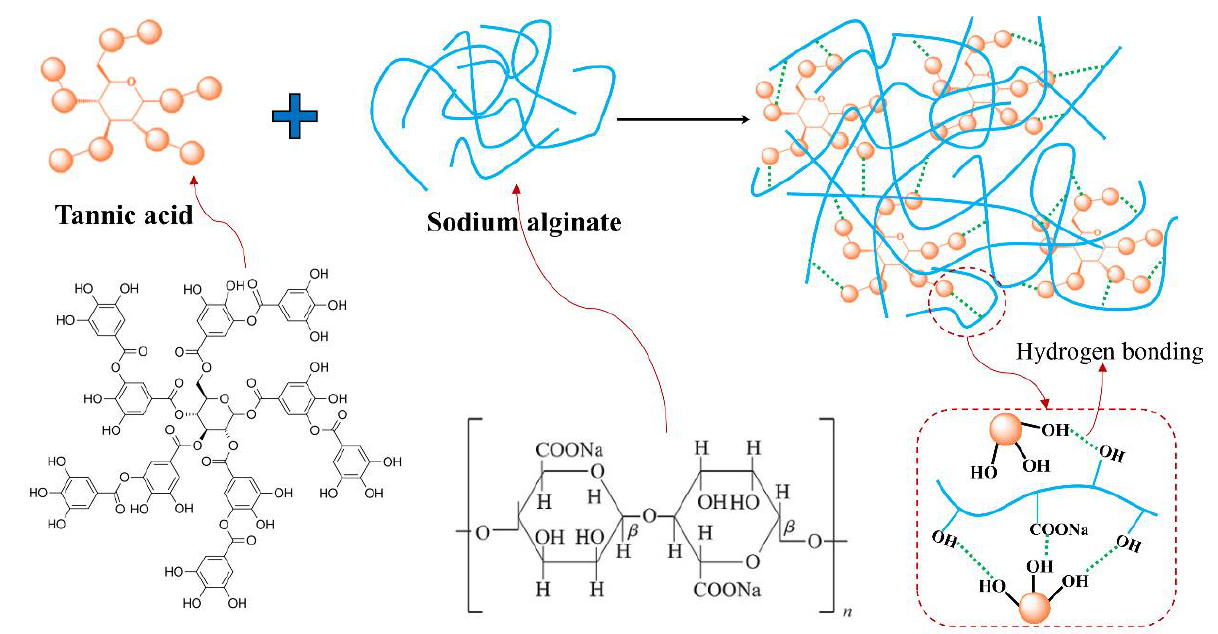
Figure 2. Illustration of intermolecular interaction between TA and SA.